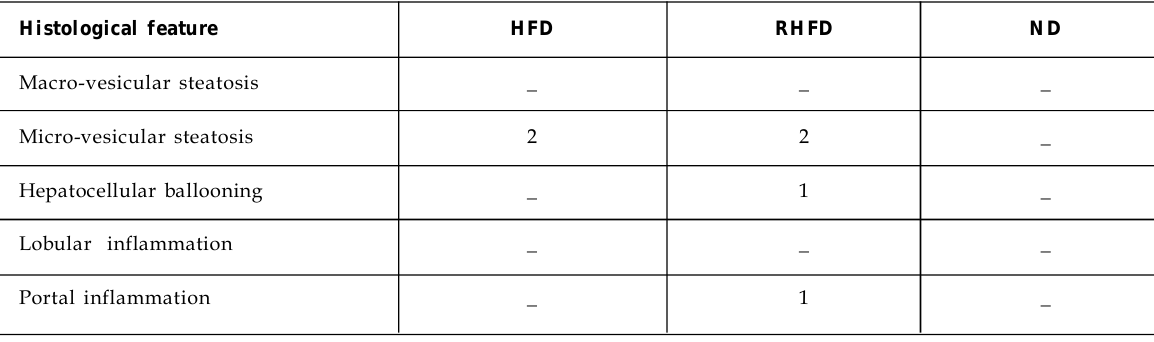
Table 1: Non-alcoholic Steatohepatitis Clinical Research Network (NASH CRN) histological grading system of the stained liver slides Histological